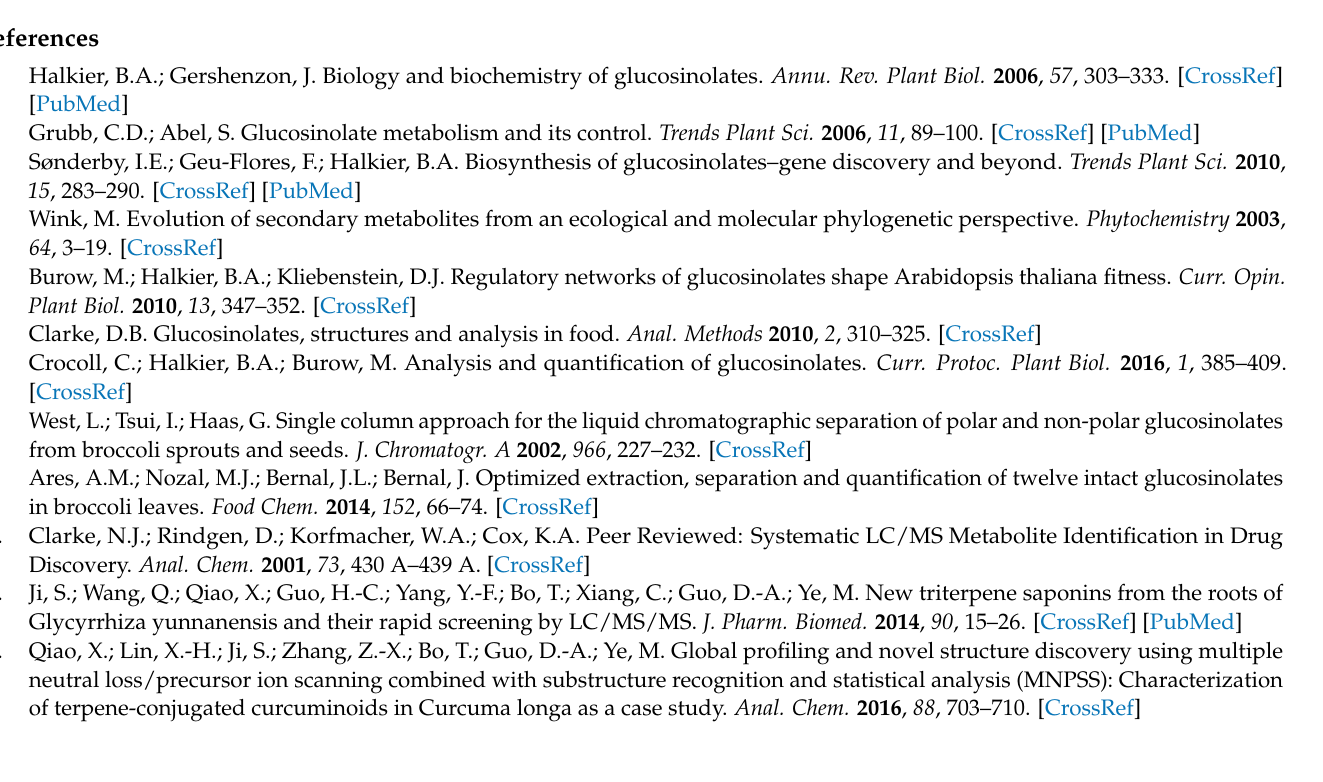
Figure S3: LC–ESI-MS chromatograms of 9 individual glucosinolates (100 ng/mL standard mixture) using a Synergi 4 µ m Fusion-RP 80 Å (250 × 2 mm) (Phenomenex) analytical column with a C18 polar embedded functionality. The chromatographic conditions were as follows: ( A ) Mobile phase “A” consisted of 100% water with 0.1 acetic acid and mobile phase “B” consisted of methanol with 0.1% acetic acid. ( B ) Mobile phase “A” consisted of 100% water with 0.1% formic acid and mobile phase “B” consisted of methanol with 0.1% formic acid. ( C ) Mobile phase “A” consisted of 100% water with 0.1% acetic acid and mobile phase “B” consisted of acetonitrile with 0.1% acetic acid, Figure S4: LC–ESI-MS chromatograms of 9 individual glucosinolates (100 ng/mL standard mixture) using three different analytical columns. ( A ) Synergi 4 µ m Fusion-RP C18 (250 × 2 mm). ( B ) Synergi 4 µ m Polar-RP 80 Å (250 × 2 mm). ( C ) Kinetex 2.6 µ m XB-C18 (100 × 2.1 mm). The mobile phase “A” consisted of 100% water with 0.1% acetic acid and mobile phase “B” consisted of methanol with 0.1% acetic acid, Figure S5: Calibration curves for each of 8 glucosinolates. The 8-point calibration curve (over a concentration range from 1.56 to 200 ng/mL) was constructed by plotting the ratios between the target analyte peak area and internal standard (sinalbin) peak area against the respective concen- trations and the curve was fitted to a linear regression function with a weight of 1/x. The calibration curve was used for the quantitative determination of each target glucosinolate in the